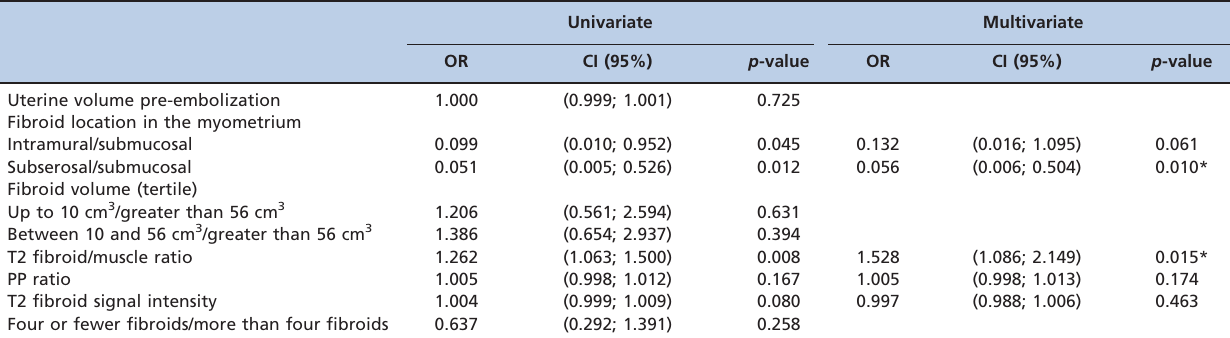
Table 3 - Univariate and multivariate analyses for factors associated with a volume reduction greater than